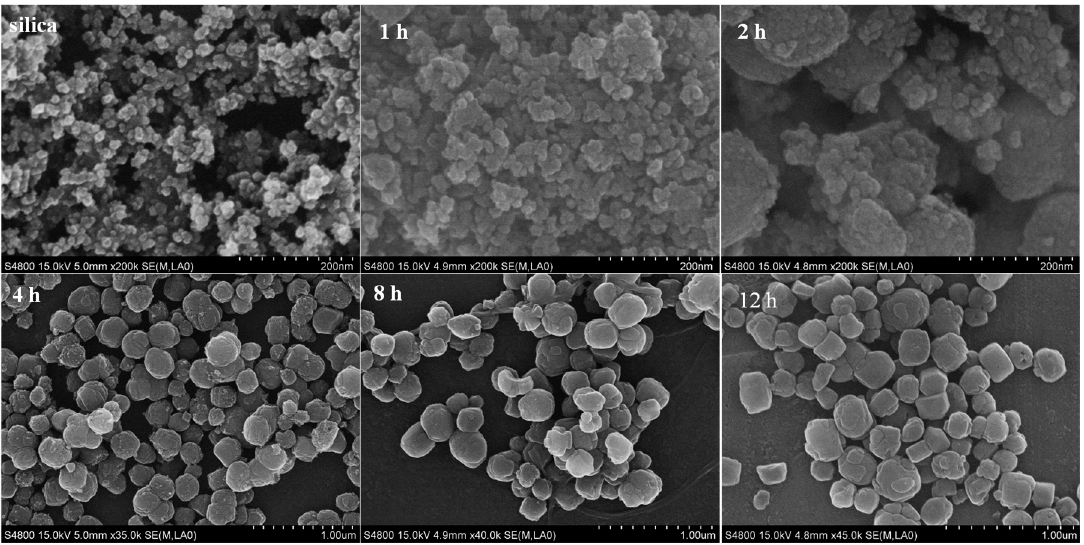
Figure 4. The SEM images of silicalite-1 synthesized from silica with particle size of 7 nm.